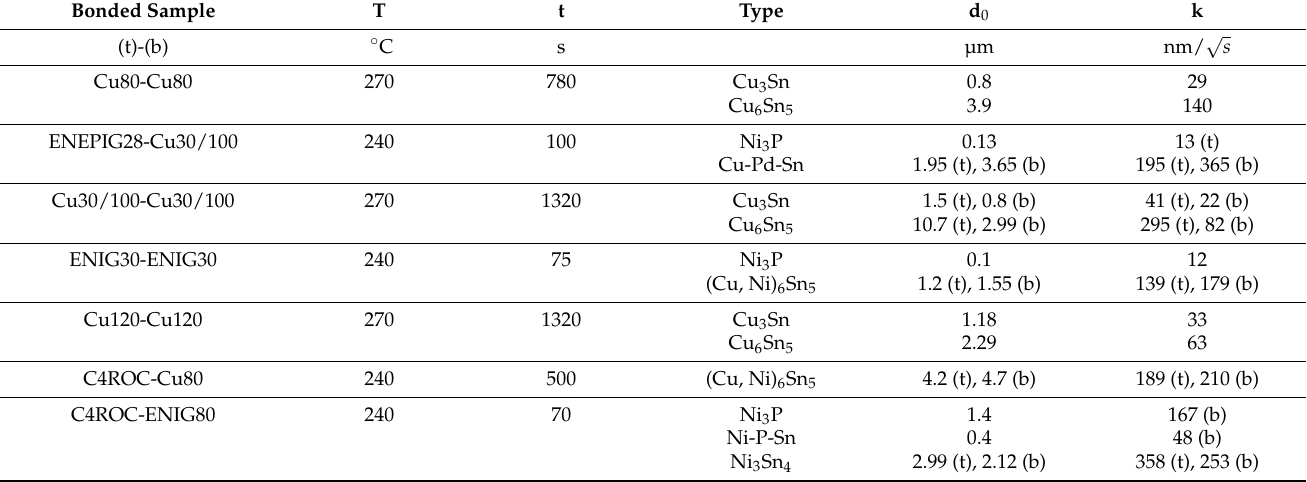
Table 3. Summary of the interfacial IMCs with peak temperatures (T), dwell times (t), thicknesses (d 0 ) and growth-rate constants (k) after the final assembly step. (t) stands for top interface and (b) for bottom UBM-solder interface, as shown in Figures 11 and